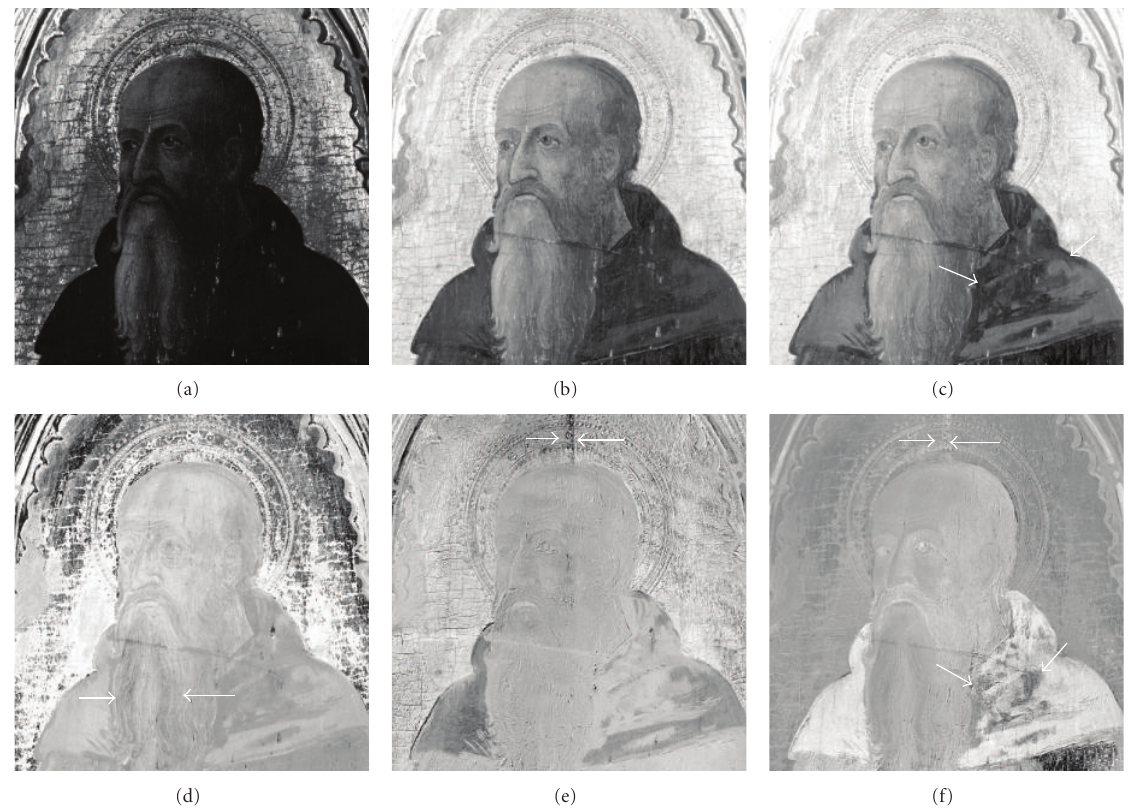
Figure 7: Detail of the upper part of the Saint from PAN (a), IR1 (b), IR2 (c), PC2 (d), PC3 (e), and NDI (f).